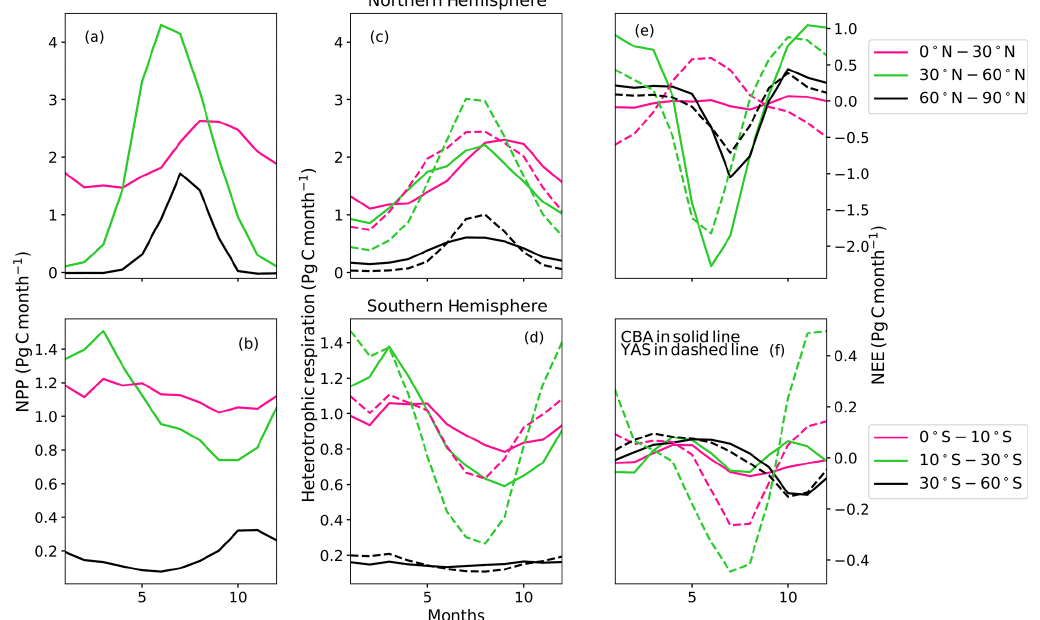
Figure 3. The annual cycle of net primary production (NPP) (a, b) , heterotrophic respiration (c, d) and net ecosystem exchange (e, f) in the Northern Hemisphere and Southern Hemisphere separated into latitudinal zones. CBALANCE (CBA) results are shown as solid lines and the Yasso (YAS) results as dashed